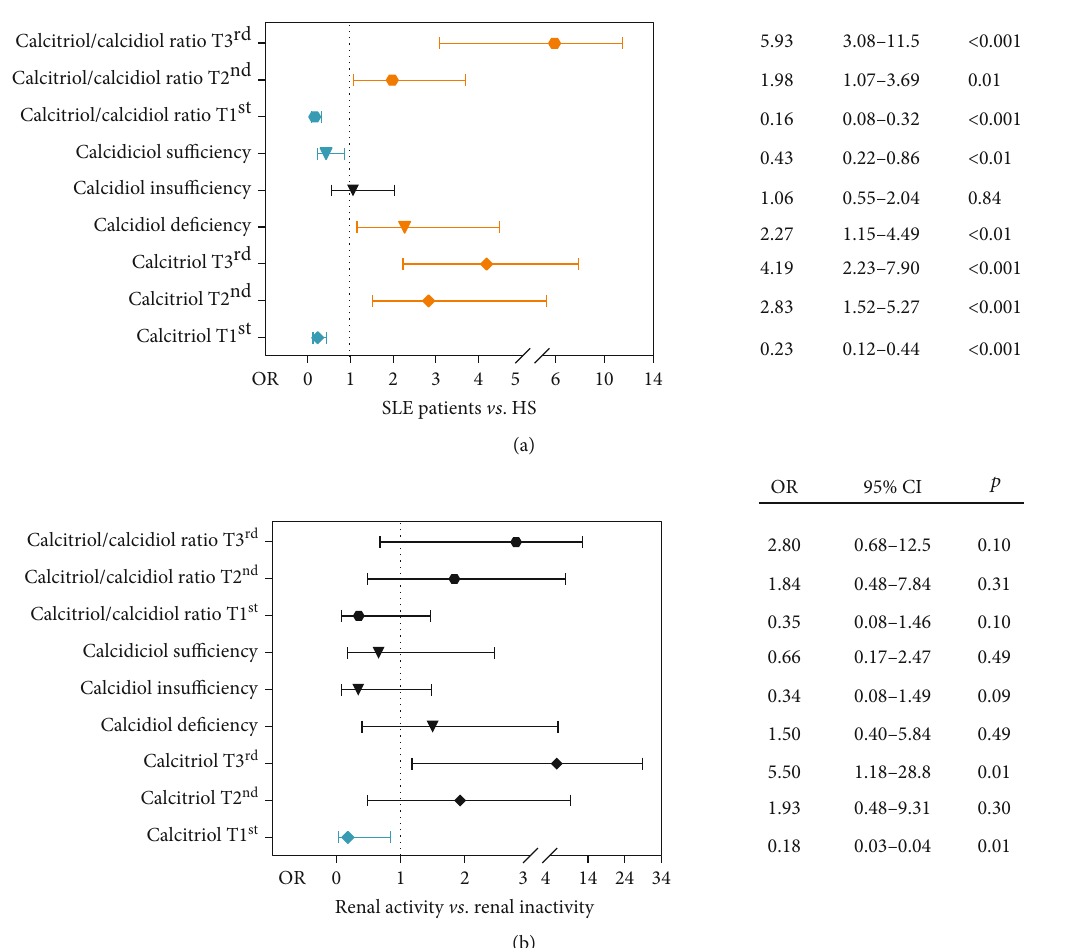
Figure 5: Association of vitamin D metabolite serum levels and vitamin D hydroxylation e ffi ciency ratio with the SLE and renal disease activity. (a) Association of vitamin D metabolite serum levels and calcitriol/calcidiol ratio with the SLE (SLE patients vs. HS); (b) association of vitamin D metabolite serum levels and calcitriol/calcidiol ratio with the presence of renal activity. HS: healthy subjects. OR: odds ratio, Fisher ’ s exact test, blue (protective OR < 1 ) and orange (risk OR ≥ 1 ) graphics, p values < 0.05, 95% con fi dence interval (CI). Black graphics: not signi fi cant di ff erences ( p > 0 : 05 ) or high con fi dence intervals. Calcitriol/calcidiol ratio tertiles: T 3 rd ( ≥ 2.23 to 23.6pg/ng), T 2 nd ( ≥ 1.36 to ≤ 2.23pg/ng), and T 1 st (0.01 to < 1.36pg/ng). Calcidiol reference values: de fi ciency ( < 20ng/mL), insu ffi ciency ( ≥ 20 to < 30ng/mL), and su ffi ciency ( ≥ 30 ng/mL). Calcitriol tertiles: T 3 rd ( ≥ 48.7 to 157.3pg/mL), T 2 nd ( ≥ 33.6 to < 48.7pg/mL), and T 1 st (0.33 to < disease activity ( OR = 0 : 18 ; p = 0 : 01 ) (Figure 5(b)). Finally,